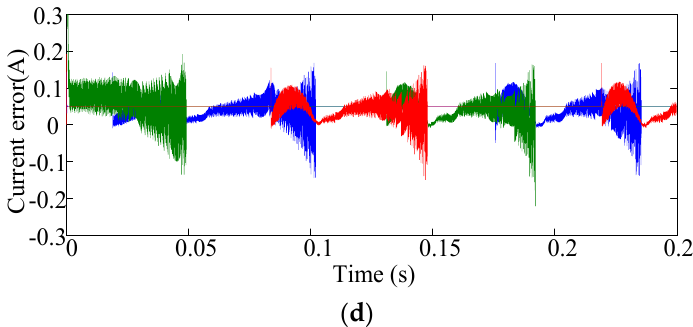
Figure 10. Simulation result when using predictive current method based on cube TSF (reference torque is set 3.7 N · m and sample time is set 1 × 10 − 4 s). ( a ) Profiles of phase current and its reference ( b ) Total torque ( c ) Phase torque ( d ) Phase current error.